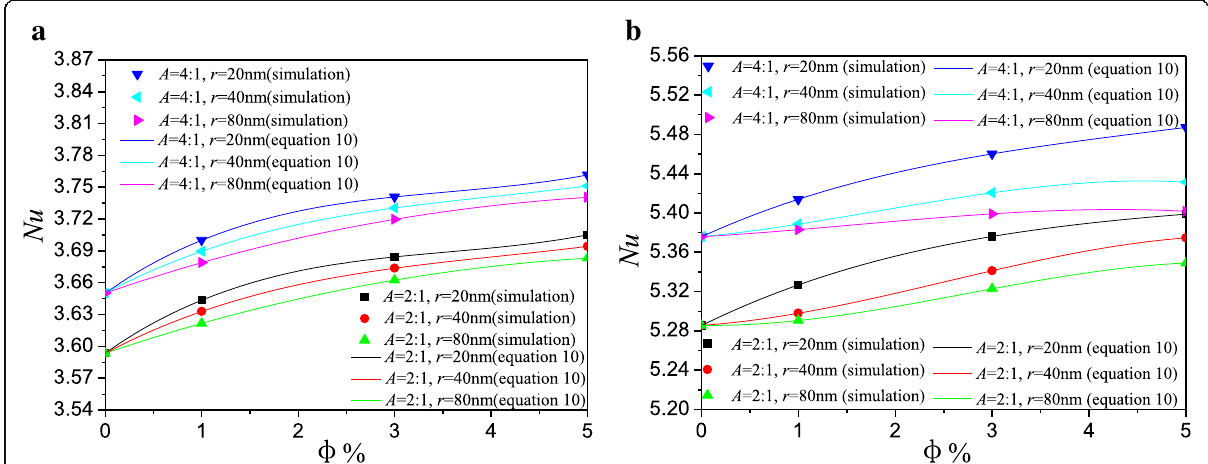
Fig. 9 Comparison of Average Nusselt numbers between A =2:1 and A =4:1. Average Nusselt numbers of Ag-Ga nanofluid with different nanoparticle radiuses along with the left hot wall. a Ra =10 3 . b Ra =10 5